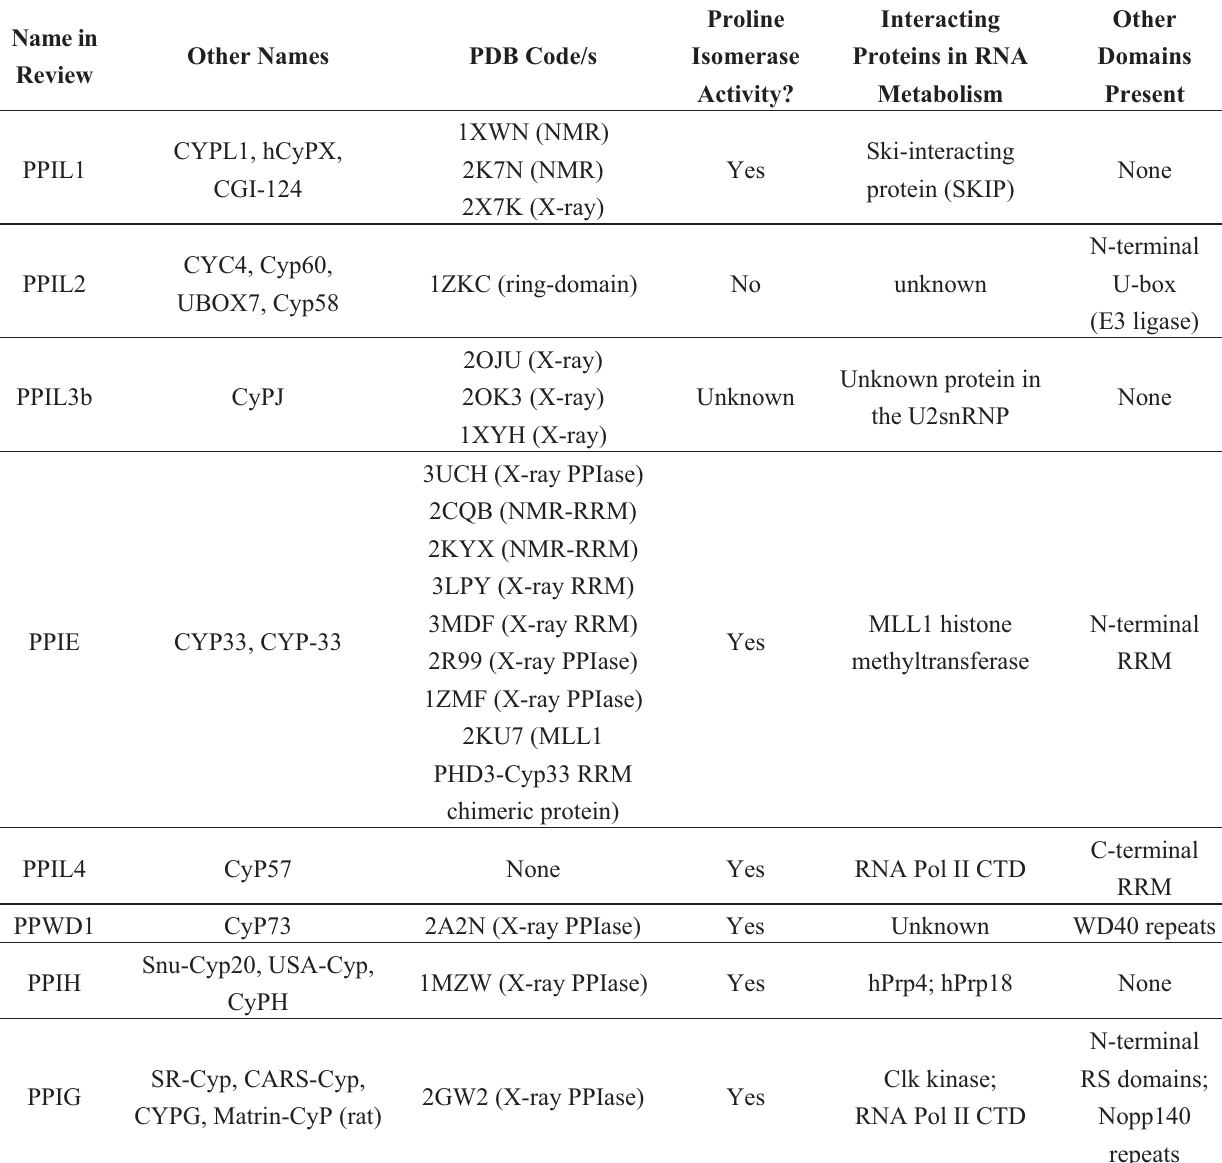
Table 1. Summary of cyclophilins involved in RNA-mediated gene